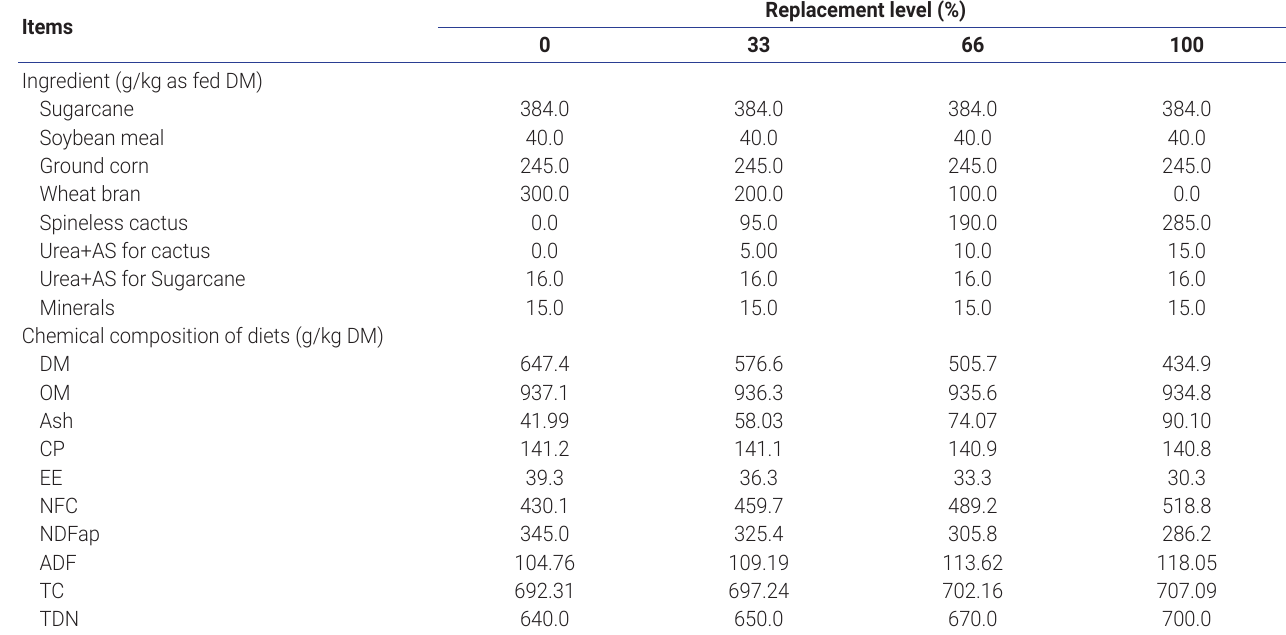
Table 1. Proportion of ingredients and chemical composition of sugarcane-based diets supplemented with spineless cactus replacing wheat